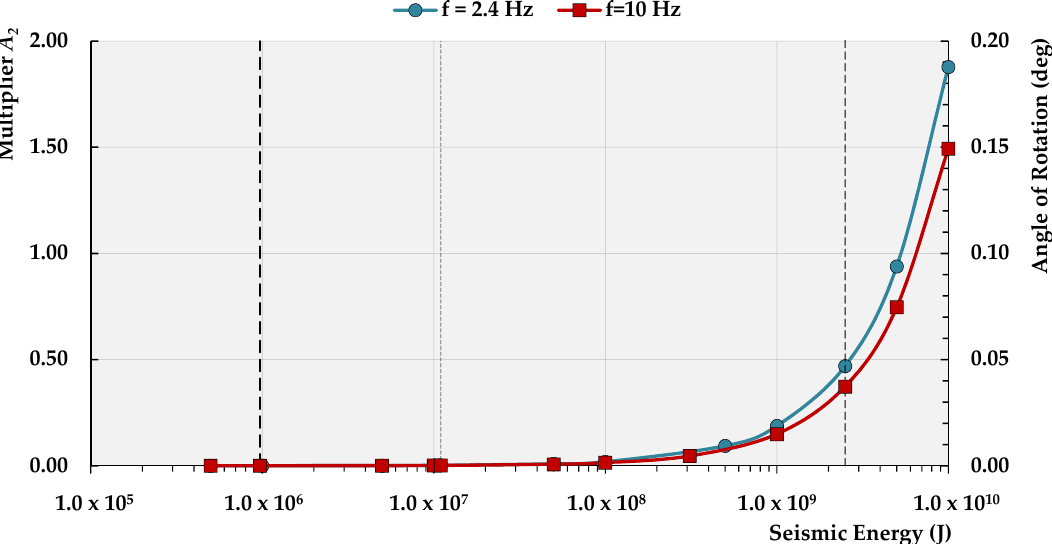
Figure 13. The relation between the seismic energy E and the multiplier A 2 values for the events that occurred at a distance of about 6000 m from the seismic measurement station.